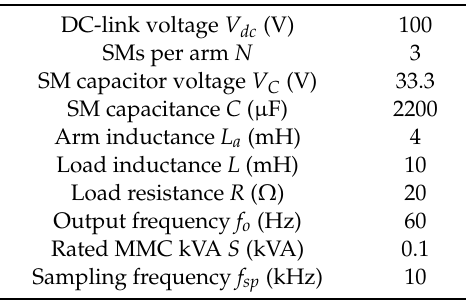
Table 3. Experimental parameters of the single-phase MMC.